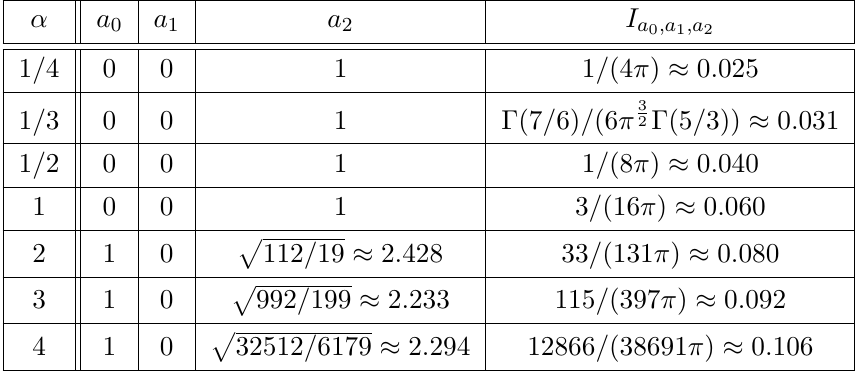
Table 1. The values of parameters that minimize I a for different values of α , where a i are 0 ,a 1 ,a 2 assumed to be real numbers (the imaginary part only contributes with a global sign in this particular case). Note that the value of I a grows with the increasing value of α . 0 ,a 1 ,a 2